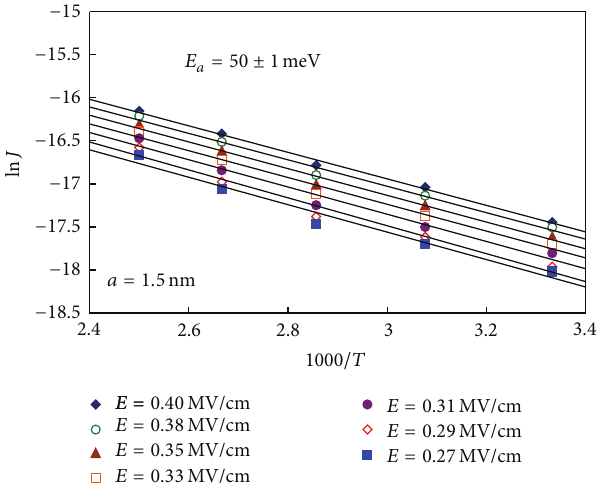
Figure 17: Arrhenius plot of the hopping conduction at low fields for the laminated Pr 2 O 3 /SiON MIS capacitors.